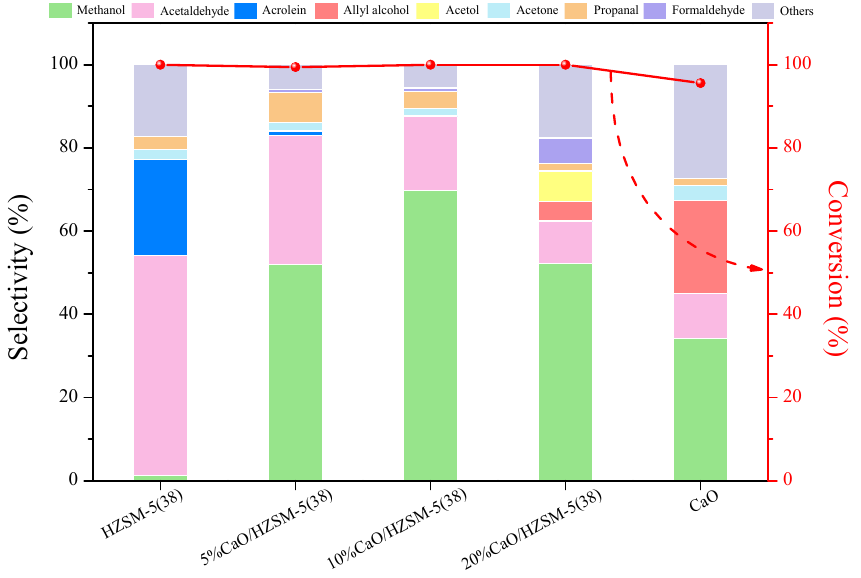
Figure 9. Glycerol conversion and products selectivity over HZSM-5(38), 5%CaO/HZSM-5(38), 10%CaO/HZSM-5(38), 20%CaO/HZSM-5(38), and CaO catalysts. Reaction conditions: T = 340 °C, feed flow = 0.01 mL min − 1 (15 wt% glycerol/H 2 O), catalyst weight = 0.20 g, inert carrier = 20 mL min − 1 , TOS = 2 h.